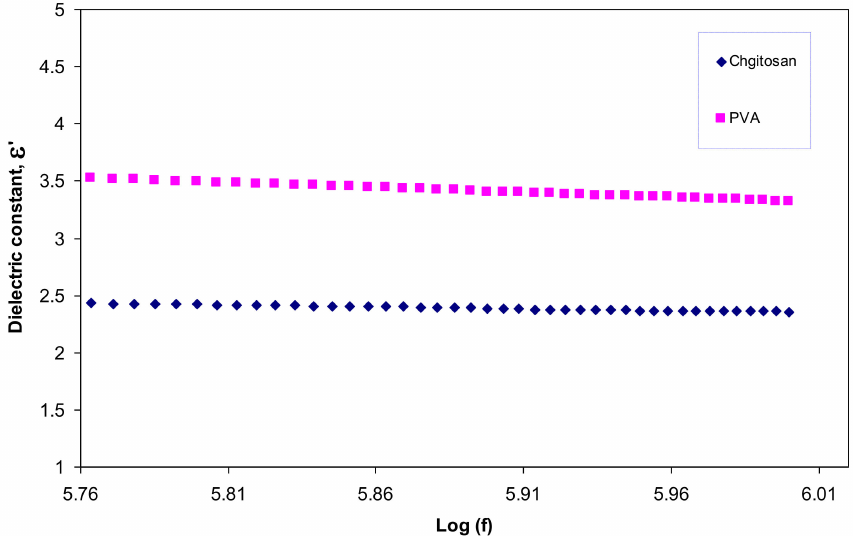
Figure 12. Dielectric constant versus frequency (high-frequency region) for pure PVA and pure